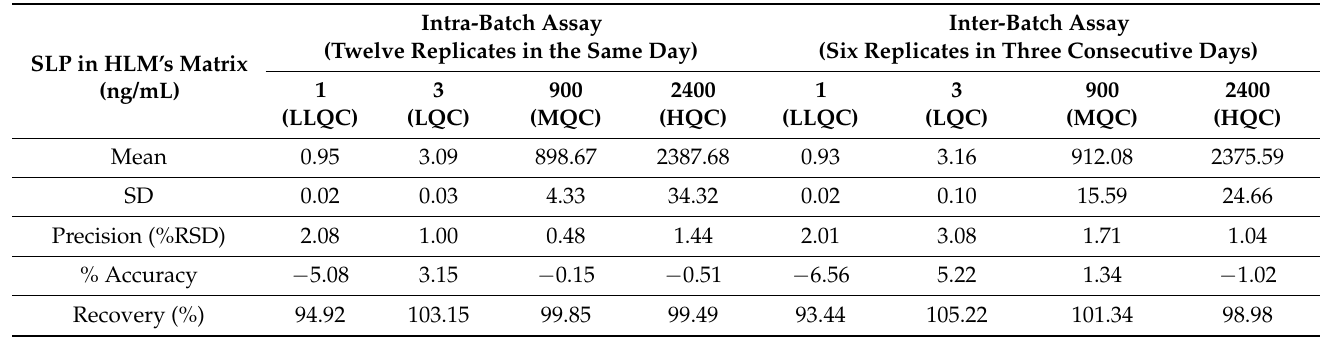
Table 2. Precision and accuracy (intra- and inter-batch) results of the LC-MS/MS